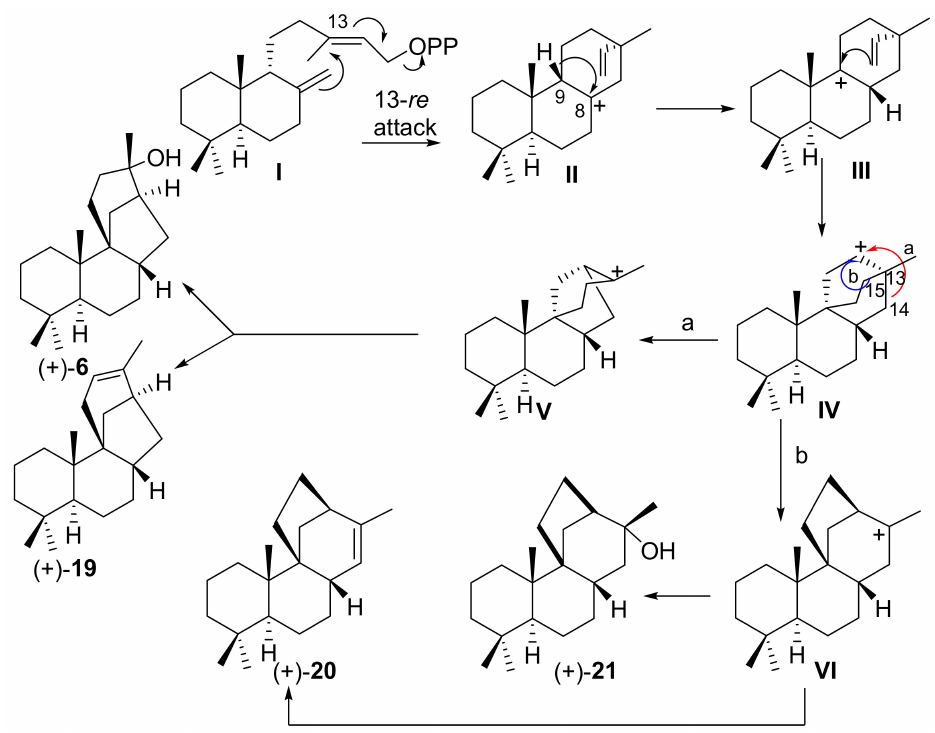
Scheme 3. Hypothesized biogenesis of stemodane and stemarane diterpenes and